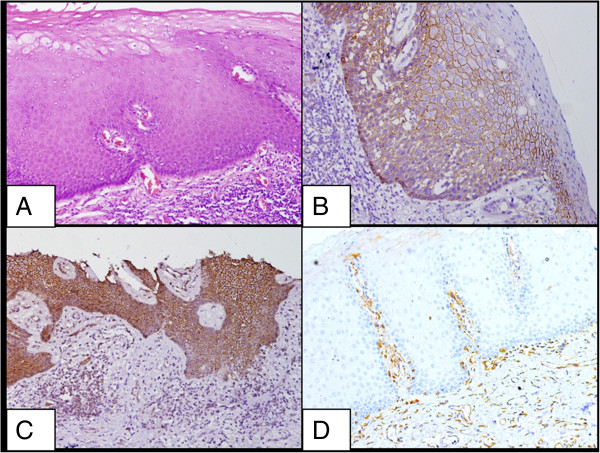
Staining pattern of oral lichen planus. A. Oral lichen planus, H&E XX200; B. High immunoreactivity for β-catenin in squamous epithelium of a case of lichen planus X200; C. High immunoreactivity for E-cadherin in squamous epithelium of a case of lichen planus X200; D. Absence of immunostaining for vimentin in squamous epithelium in a case of lichen planus X200.